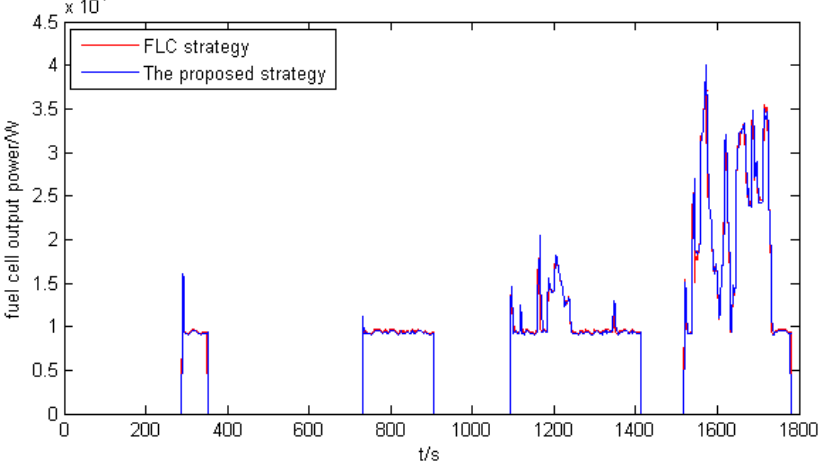
Figure 9. Output power comparison between fuzzy control and compound energy management.